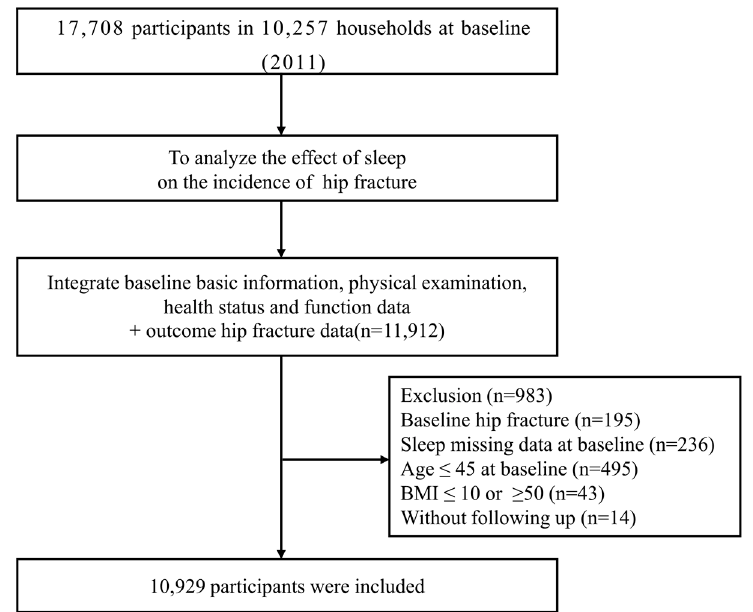
Figure 1. Flowchart of baseline data exclusions.